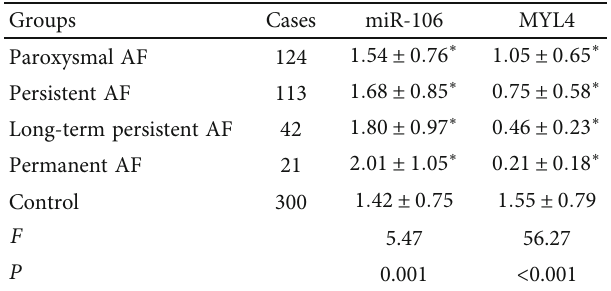
Figure 2: Expression of miR-106 and MYL4 in right atrial appendage atrial muscle tissue of patients with AF and sinus rhythm ( × 400). (a) miR-106 expression in AF myocardium; (b) miR-106 expression in sinus rhythm myocardium; (c) MYL4 expression in AF myocardium; (d) MYL4 expression in the sinus rhythm myocardium. Table 3: Comparison of serum miR-106 and MYL4 levels in Table 4: Prevalence of AF in patients with di ff erent levels of miR- patients with di ff erent types of AF ( (cid:1) x ± s ). 106 and MYL4 [ n